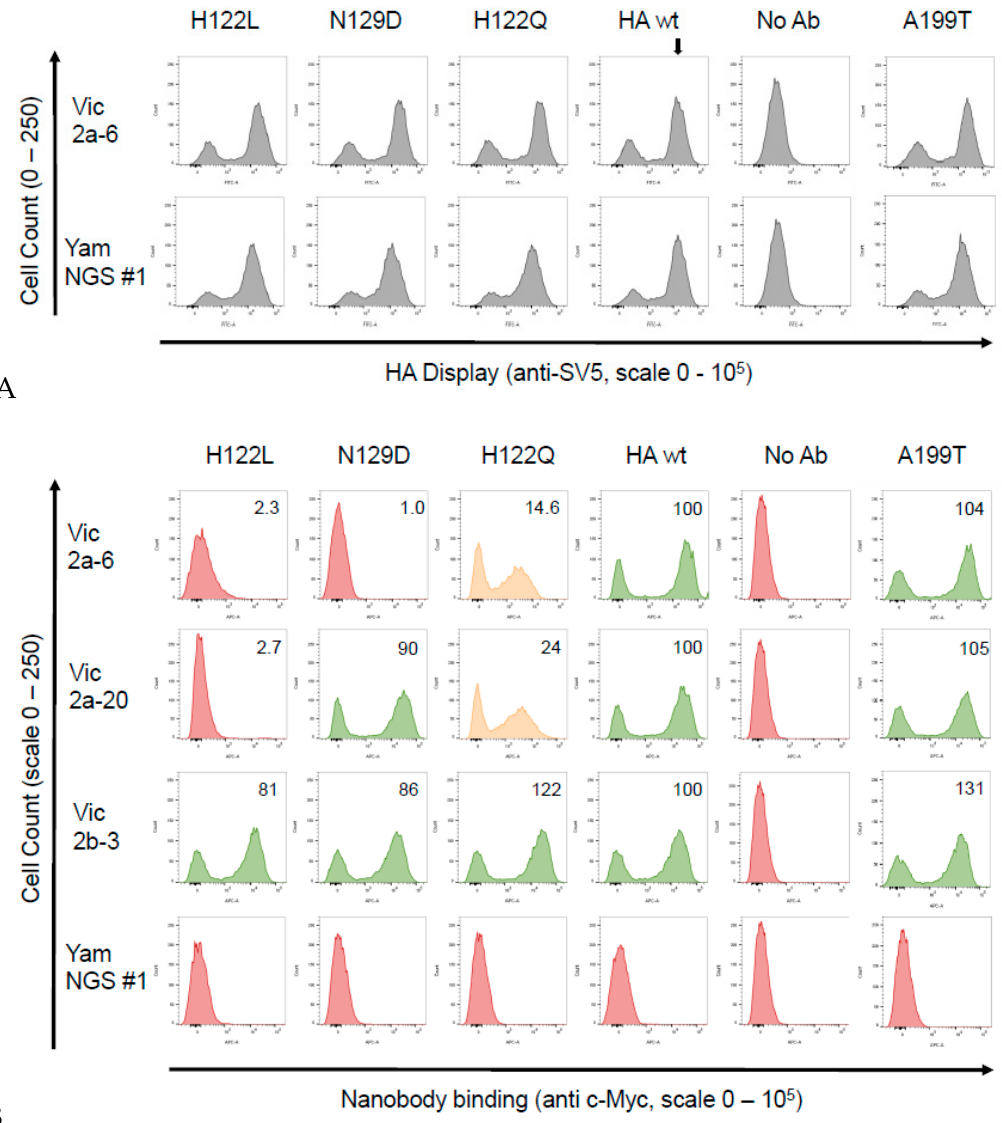
Figure 4. Binding of the sdAbs to the B-Victoria single residue mutant HA0’s. Candidate single residue mutations predicted to correlate with lineage-specific binding and a naturally occurring substitution H122Q, which differentiated between the B-Victoria and B-Yamagata strains, were generated and binding was tested using yeast display and flow cytometry. ( A ) Detection of the HA0 display level, using detection of the SV5 epitope tag attached to the HA0, showing that the mutations had no effect on the HA0 display level relative to the wild-type (wt) HA0 (indicated by vertical arrow). ( B ) Flow cytometry histograms showing binding of the Vic2a-6, Vic2a-20, Vic2b-3 and the YamNGS#1 to the wild-type HA (B/Brisbane/60/2008 precursor HA0) and selected mutants (the positive population is the right peak, whereas, the left peak shows the unbound and unstained populations). Mutations that completely eliminated sdAb binding are shown in red, those that partially affected binding are shown in orange and those that had no effect are shown in green. We determined the extent of sdAb binding by dividing the geometric mean fluorescence intensity (MFI) of each sdAb mutant pair by the value of the MFI of the wild-type B-Vic HA sdAb interaction and the resulting ratio, normalised to a percentage value of the wild-type interaction. Relative binding of the sdAbs was categorised as ‘no binding’ (in red)—< 5%; ‘intermediate binding’ (in orange)—between 20–40%; and ‘strong binding’ (in green)—> 40%; shown in the upper right-hand quadrant of the flow cytometry histograms. Graphs shown are a representative of at least two independent